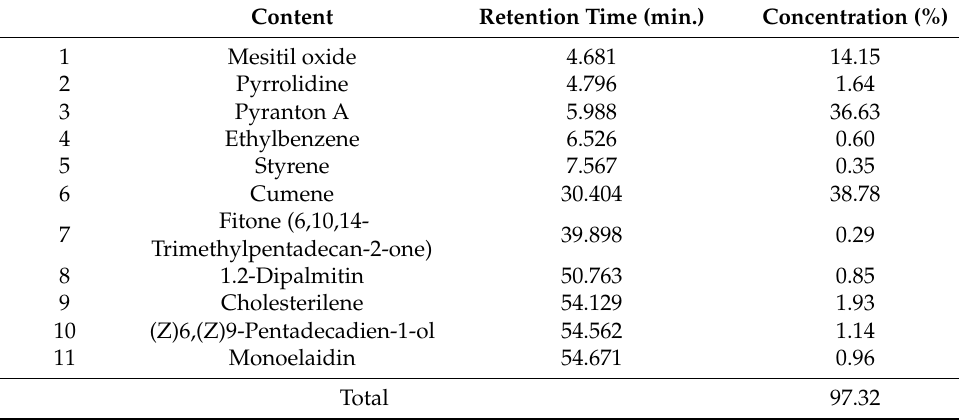
Table 1. Volatile compounds of tomato paste by-products